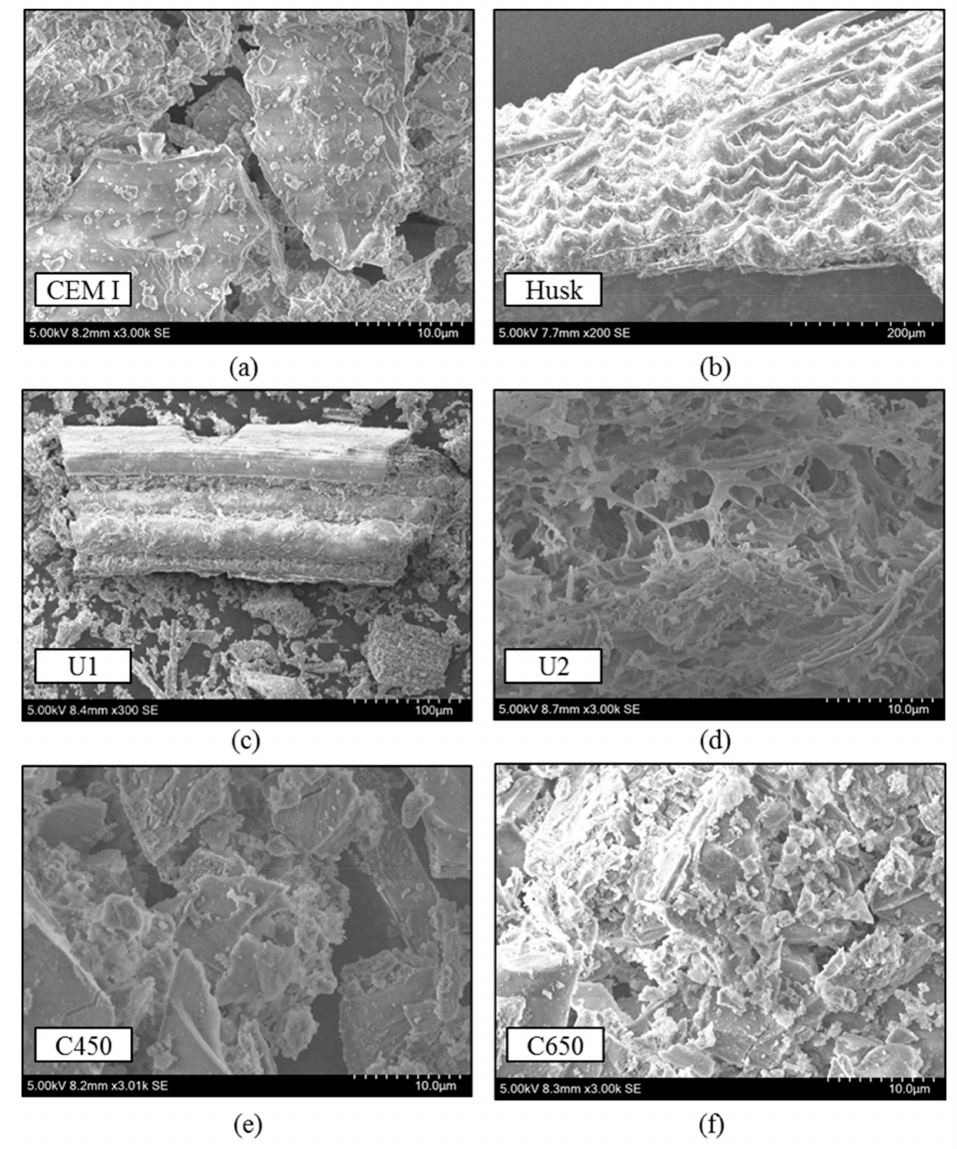
Figure 5. Characteristic scanning electron microscopy (SEM) graphics for: ( a ) CEM I 42.5 R, ( b ) the husks, ( c ) U1, ( d ) U2, ( e ) C450 and ( f )